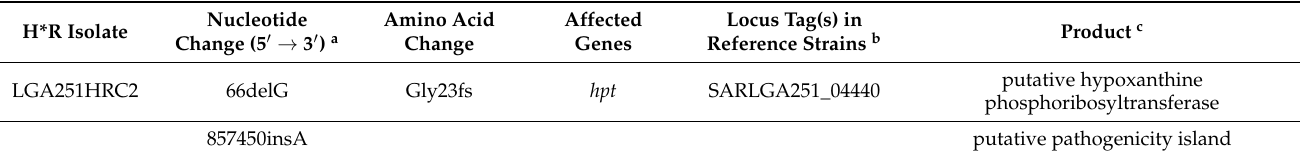
Table 1. Mutated loci identified in high oxacillin resistant (H*R) isolates carrying different methicillin genetic